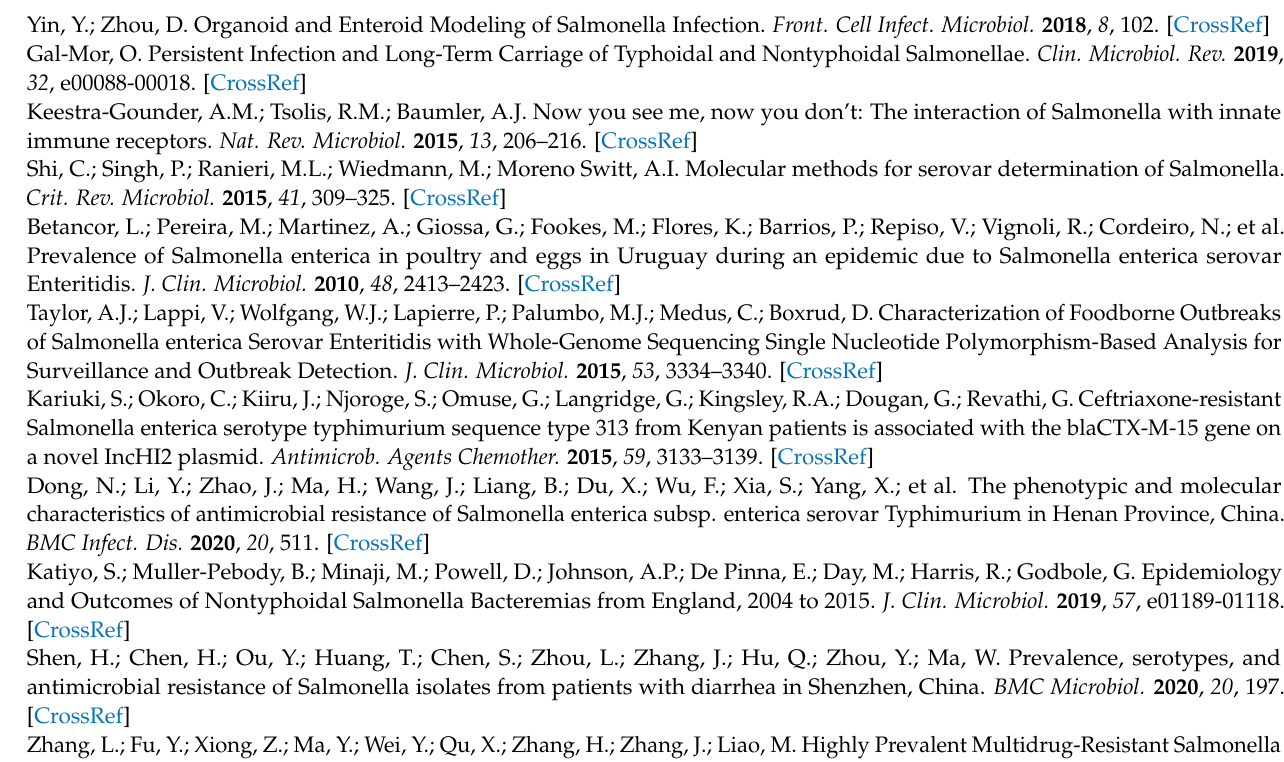
Table S4: Distribution of the minimum inhibitory concentrations (MICs) of seven cephalosporins against ESBL-producing S. Enteritidis isolates ( n = 233). Table S5: PFGE pattern, clinical background Table S6: Antibiotic resistance profiles of donor strains, recipient strains, and transconjugants, and the conjugation frequency of ESBL-encoding genes. Black squares denote the presence of resistance to a given antimicrobial